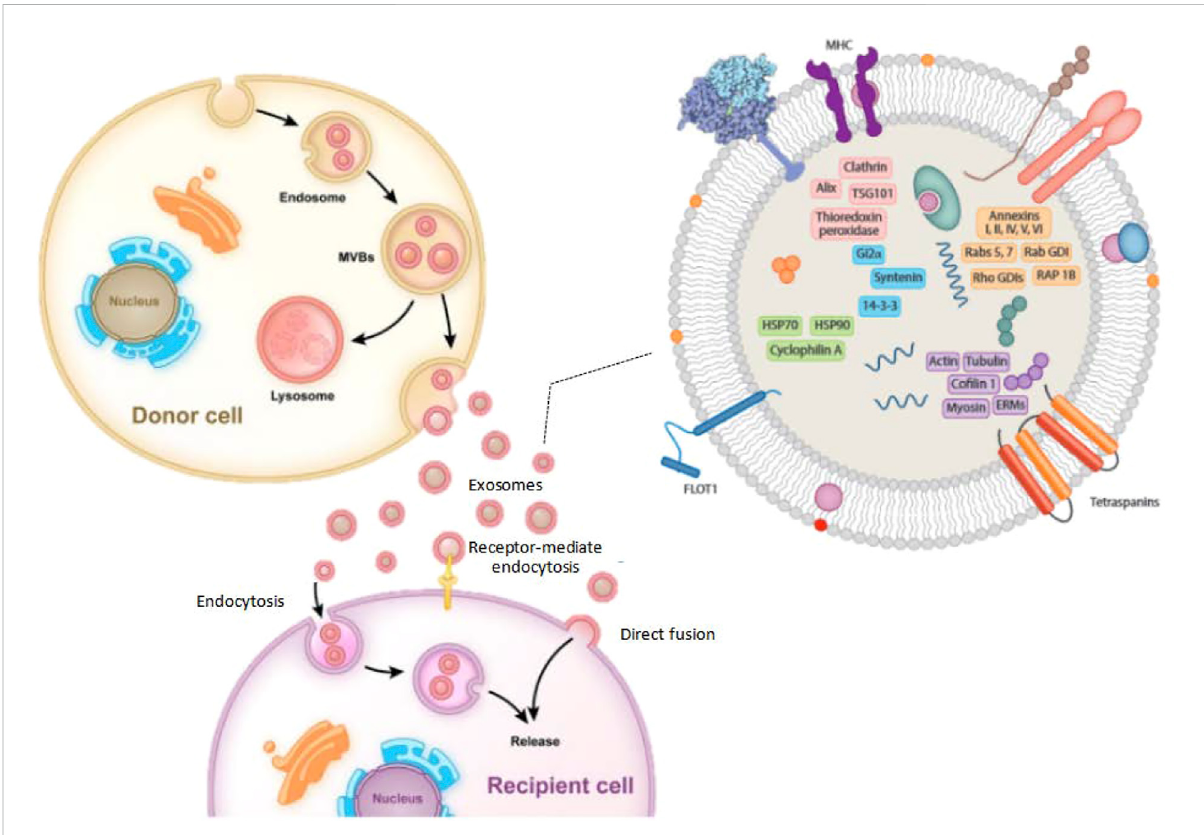
FIGURE 1 The typical processes of exosome production, secretion, and transfer from donor cells to recipient cells, as well as the structure of